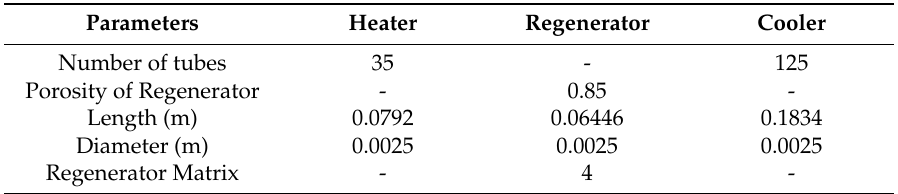
Table 4. Parameters of the RE-1000 FPSE [18].